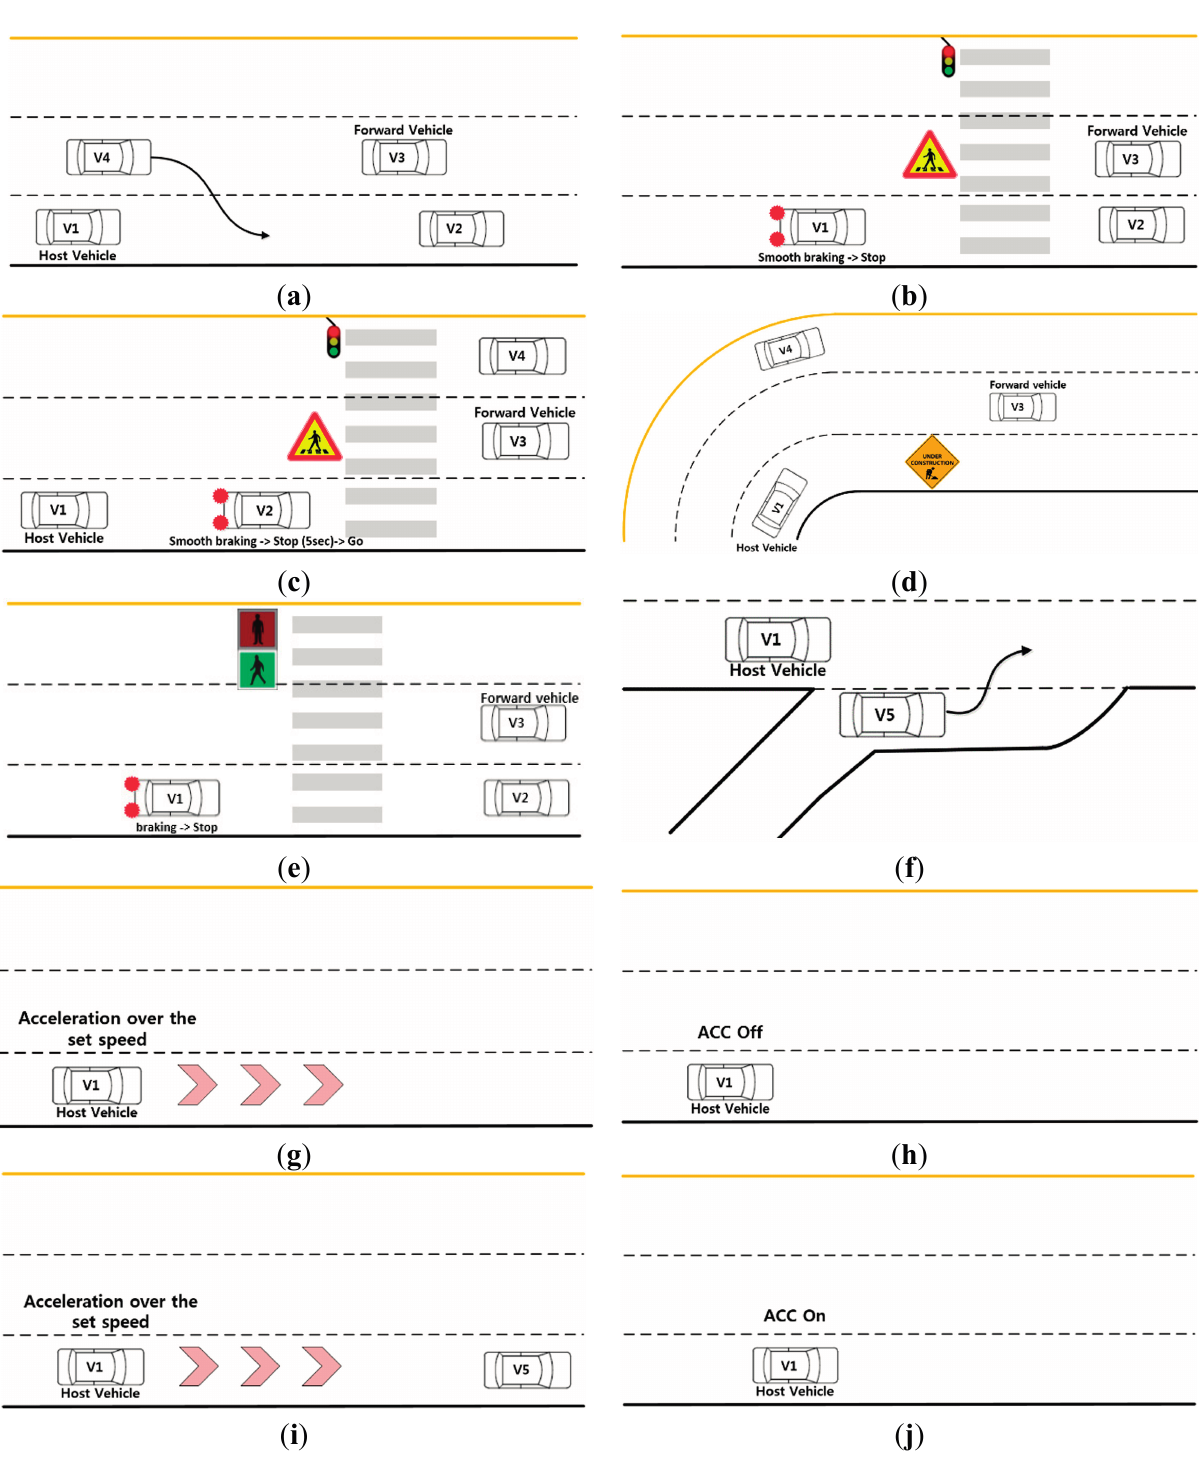
Figure 12. Ten events used in the driver-in-the-loop experiments to evaluate the ACC interfaces: ( a ) Event 1: V 4 suddenly moves in front of V 1 ; ( b ) Event 2: V 1 encounters a red traffic light and must stop; ( c ) Event 3: V 2 stops smoothly because of a red traffic light; ( d ) Event 4: V 1 must stop because of a construction zone; ( e ) Event 5: V 1 encounters a red traffic light and must stop suddenly; ( f ) Event 6: V 5 moves suddenly in front of V 1 from an entrance ramp; ( g ) Event 7: V 1 must accelerate; ( h ) Event 8: V 1 must turn off the ACC system; ( i ) Event 9: V 1 must accelerate; and ( j ) Event 10: V 1 must turn on the ACC